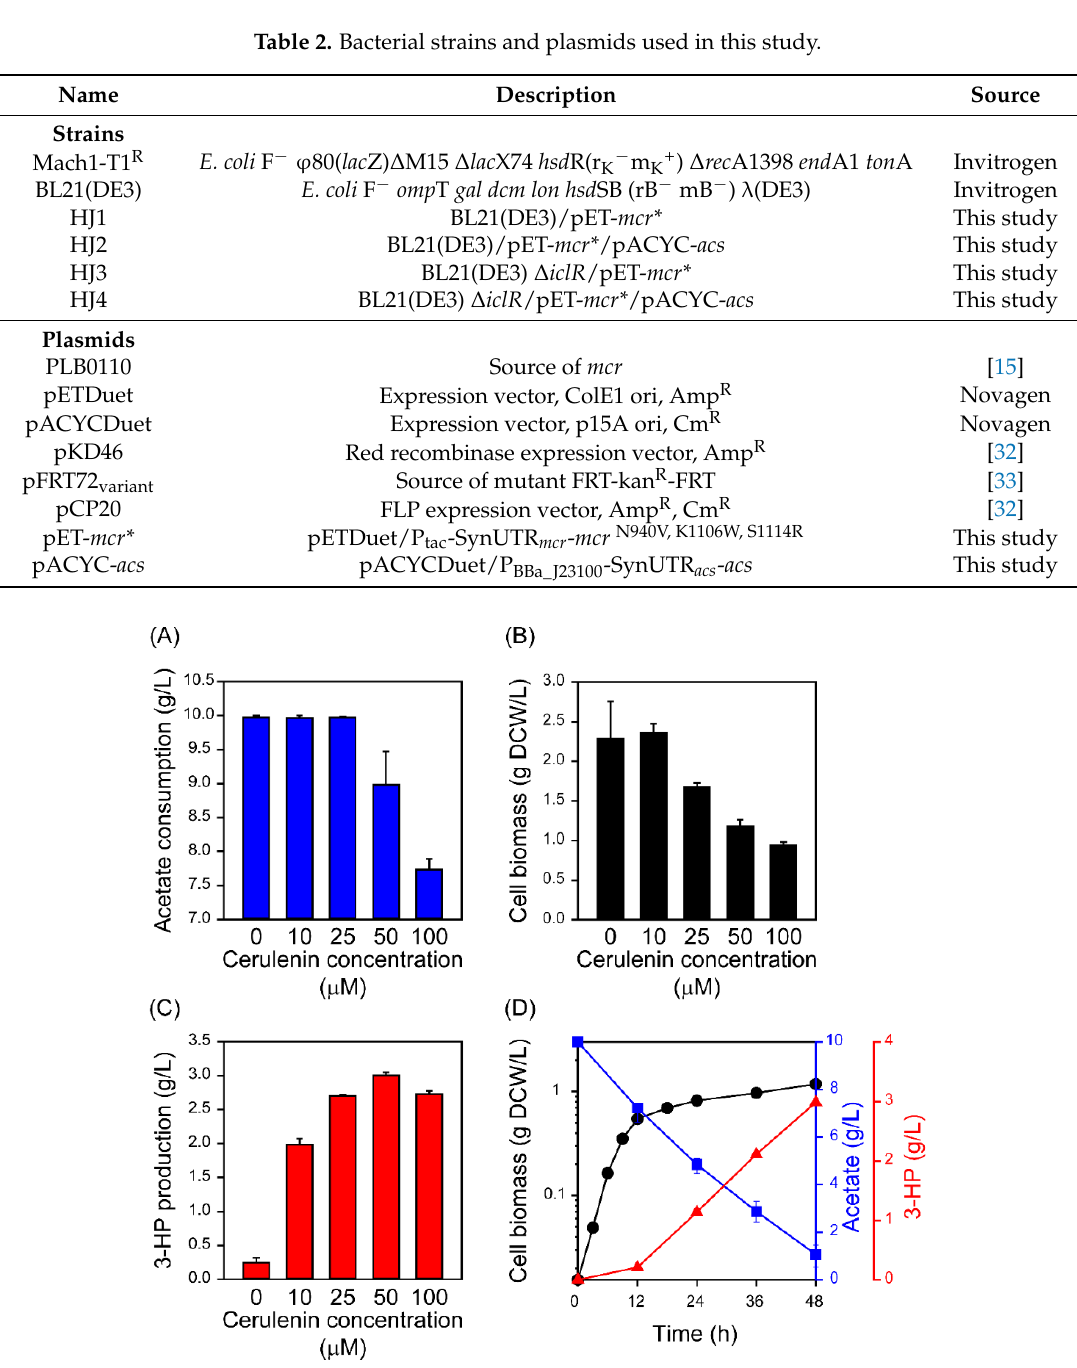
Figure 4. Improved 3-HP production with the addition of cerulenin. ( A ) Acetate consumption (g/L), ( B ) cell biomass (g DCW/L) and ( C ) 3-HP (g/L) production of the HJ4 strain with different cerulenin concentrations after 48 h fermentation. ( D ) Time-course fermentation profile (48 h) of the HJ4 strain with 50 µ M of cerulenin in a modified acetate minimal medium. The left y-axis, right y-axis and right y-offset represent the cell biomass (g DCW/L), acetate (g/L) and 3-HP (g/L), respectively. The x-axis denotes time (h). Symbols: circles, cell biomass; squares, acetate; triangles, 3-HP. The error bars indicate standard deviations for measurements from three independent cultures.